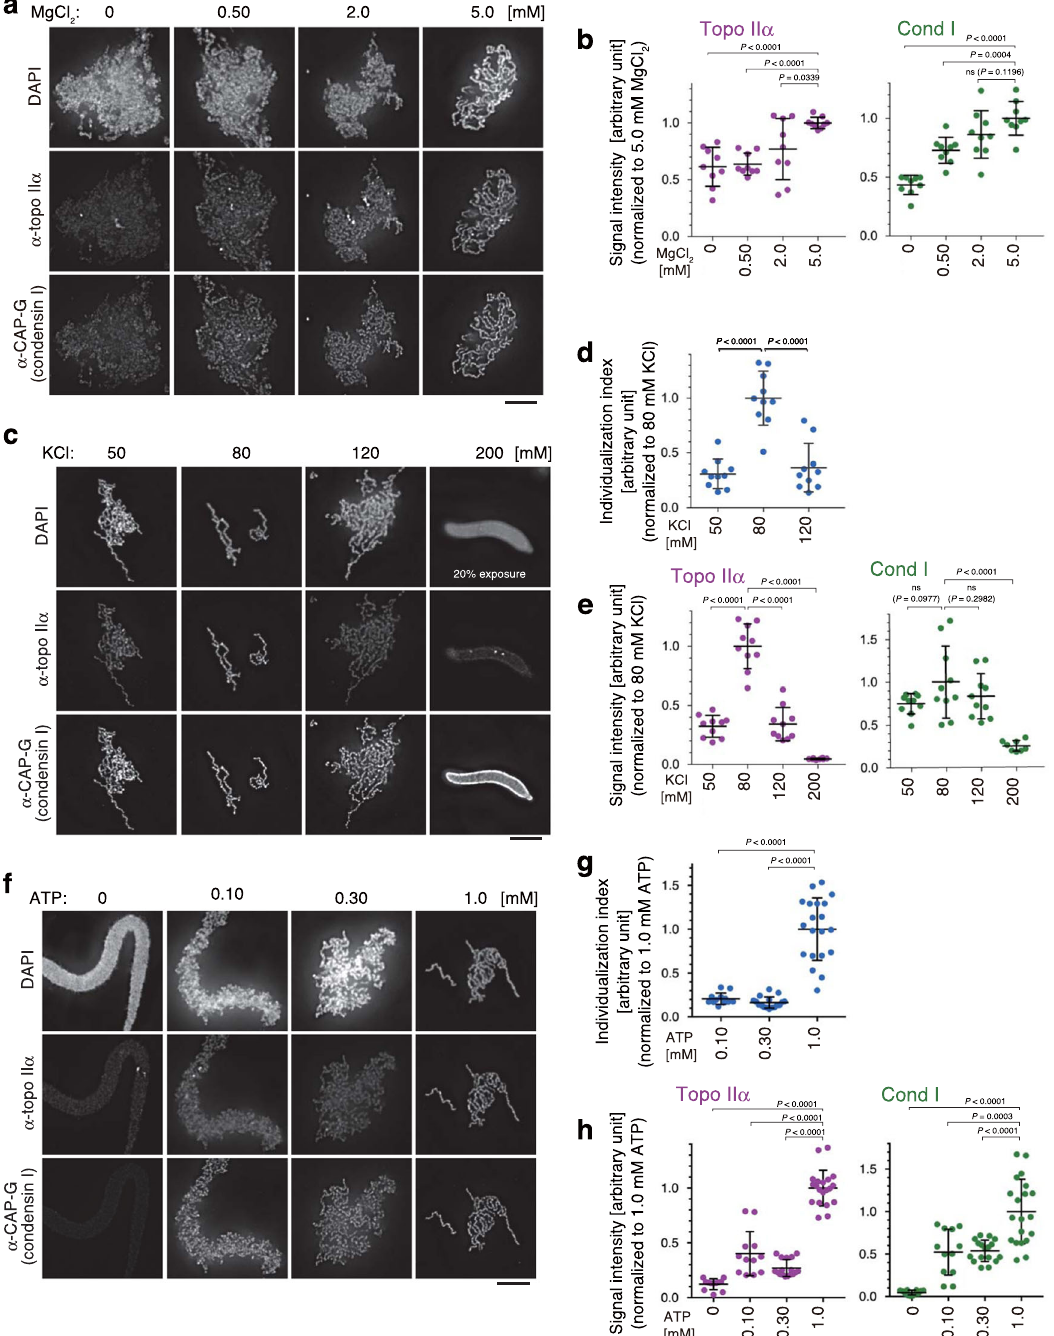
Fig. 1 Manipulation of buffer conditions in the mitotic chromatid reconstitution assay. a , b Xenopus sperm nuclei were mixed with a cocktail of six puri fi ed proteins (topo II α , condensin I, a truncated version of histone H2A.XF-H2B dimer, Npm2, Nap1, and FACT) in a buffer containing no MgCl 2 or increasing concentrations of MgCl 2 . The concentrations of other chemical ingredients in the buffer are listed in Table 1. After a 150-min incubation at 22 °C, the resultant structures were fi xed and labeled with antibodies against topo II α and CAP-G (a subunit of condensin I). DNA was counterstained with DAPI ( a ). Integral signal intensities of topo II α or CAP-G were divided by those of DAPI in the same segmented region, and the values normalized to the average value in the reaction containing 5.0 mM MgCl 2 are plotted. The mean ± s.d. is shown ( n = 9 clusters of chromatin). P values were assessed by two-tailed Welch ’ s t -test (ns, not signi fi cant) ( b ). c – e KCl concentrations were titrated in the reconstitution assay. Immunolabeling and signal quanti fi cation were carried out as above ( c , e ). The perimeter of a DAPI-positive segmented area was divided by the integral intensity of DAPI in the same area, and the resultant values are plotted as individualization indices ( d ). The mean ± s.d. is shown. The sample sizes ( n , the number of clusters of chromatin) are 10 (50, 80, and 120 mM KCl) and 8 (200 mM KCl). P values were assessed by two-tailed Welch ’ s t -test (ns, not signi fi cant) ( d , e ). f – h ATP concentrations were titrated in the reconstitution assay ( f ). Individualization indices and signal intensities were analyzed as above. The mean ± s.d. is shown. The sample sizes ( n , the number of clusters of chromatin) are 12 (0 and 0.10 mM ATP), 17 (0.30 mM ATP) and 20 (1.0 mM KCl). P values were assessed by a two-tailed Welch ’ s t -test. ns not signi fi cant ( g , h ). Bars, 5 µ m.